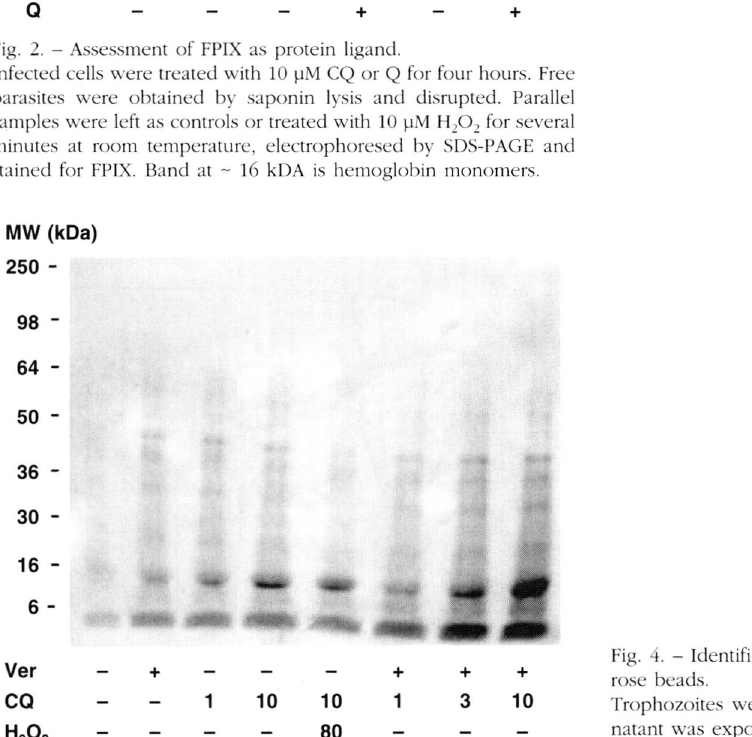
0 for several 2 2